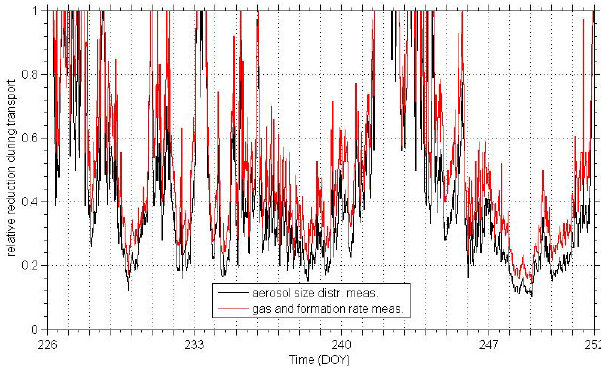
Figure 5. Relative reduction of concentrations during transport from the forest edge to the hill top depending on the present wind direction and speed. This factor is used for scaling the measured VOC concentrations to obtain values after transport.